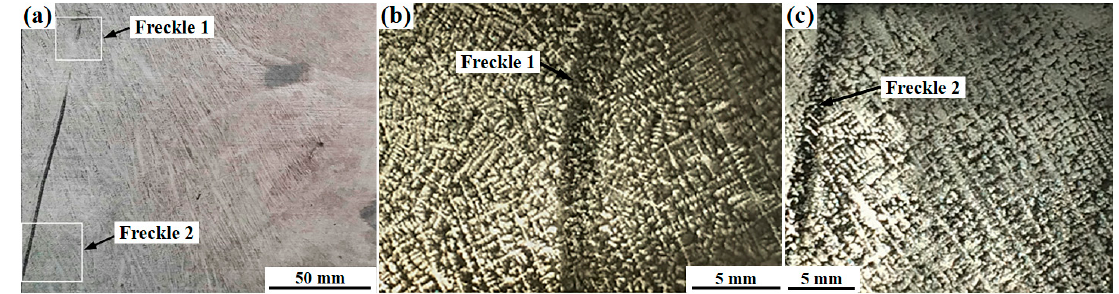
Figure 2. Macrostructure of freckles in the GCr15SiMn ESR ingot. ( a ) freckle on ingot, ( b ) macrostructure of freckle 1, ( c ) macrostructure of freckle 2.